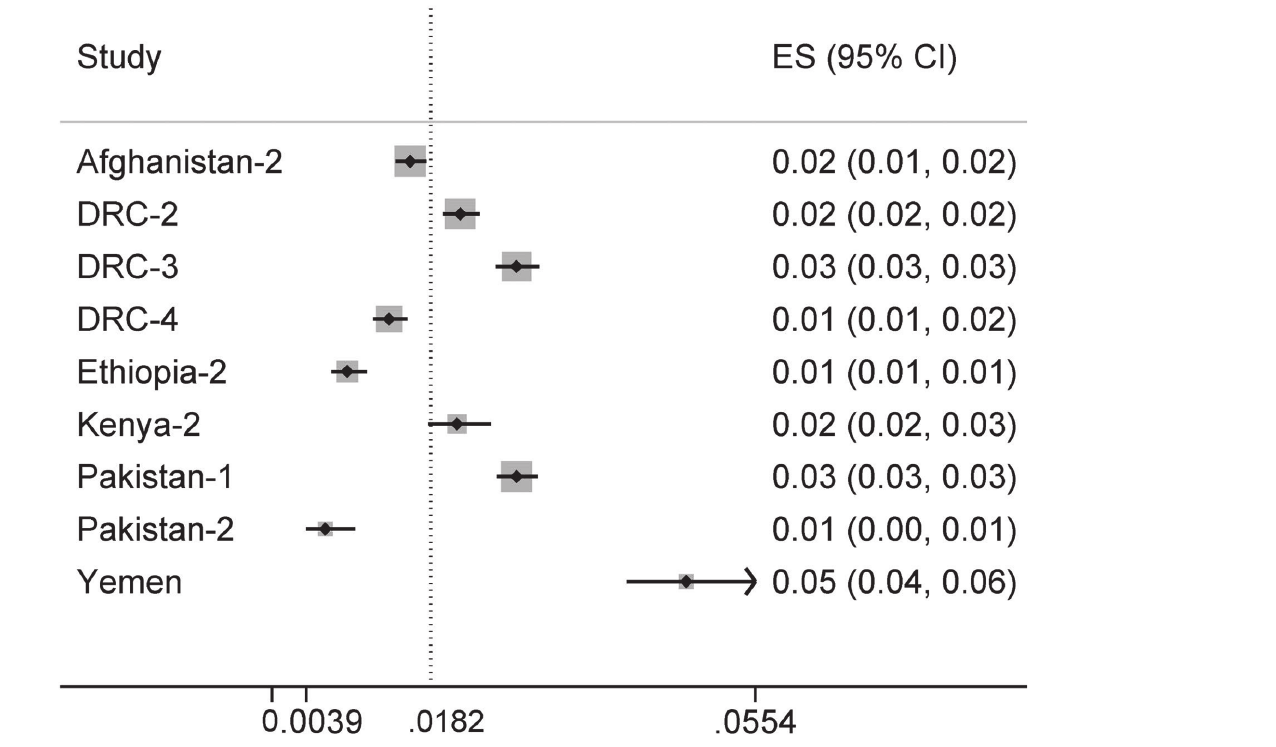
Fig 4. Forest plot of the proportion of any form of TB among screened household contacts of TB